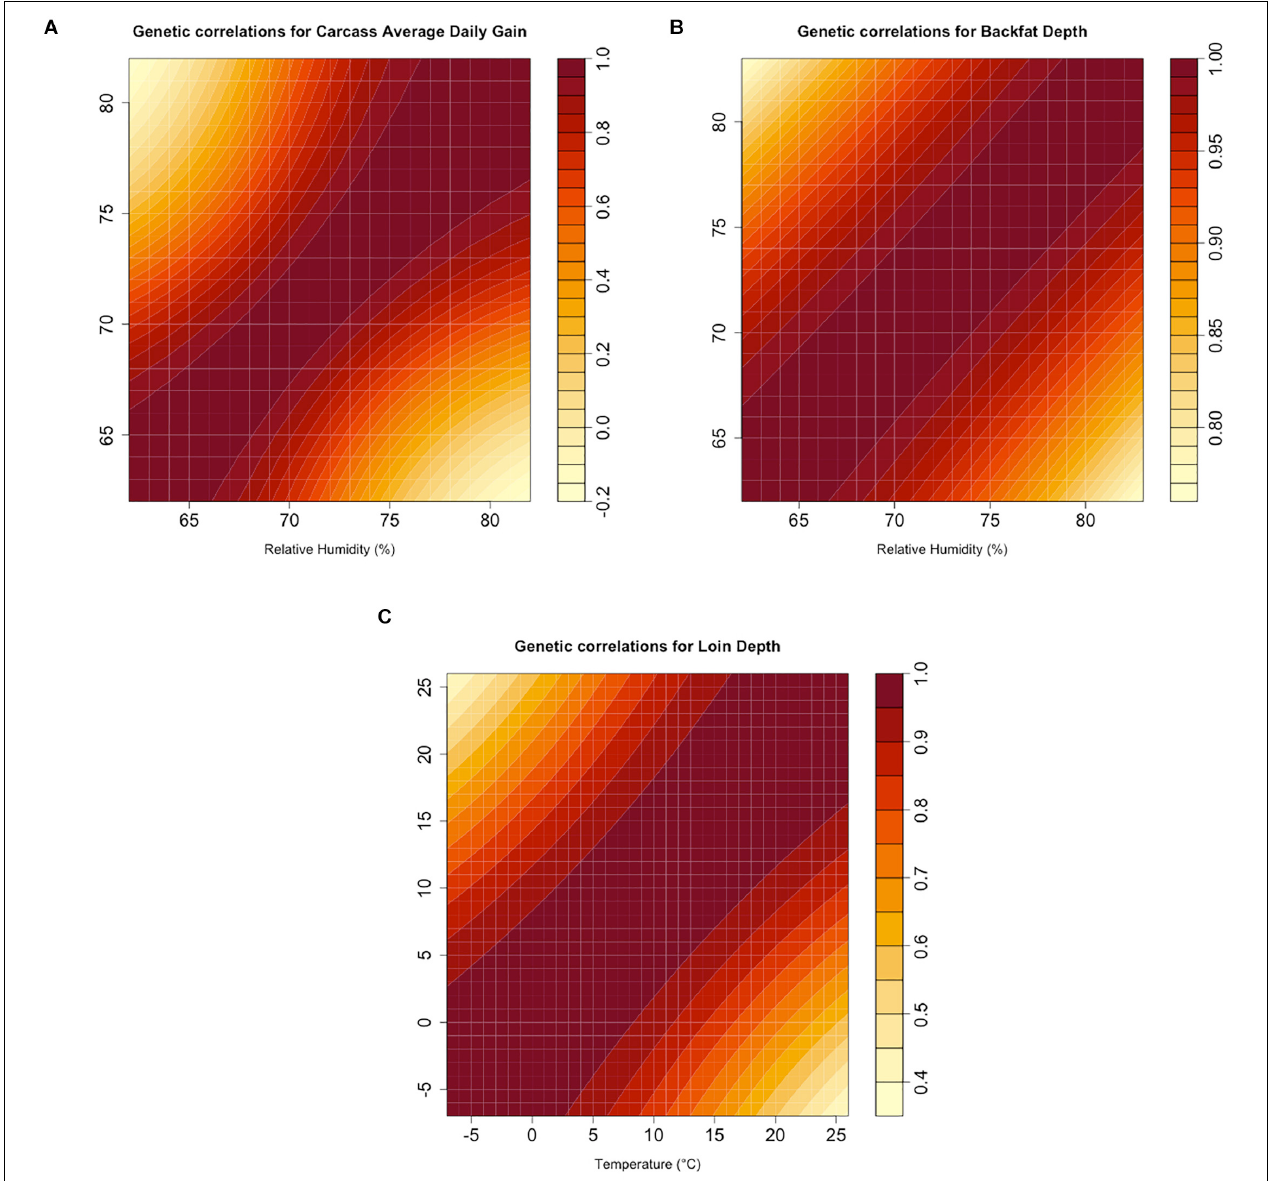
FIGURE 3 | (A–C) . Estimates of additive genetic correlations using the genomic random regression model (2) for the corresponding climatic variable and carcass quality trait combinations.